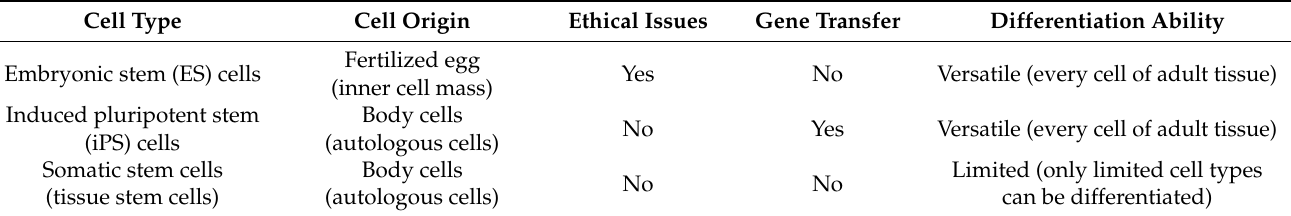
Table 2. Typical stem cells used in regenerative medicine